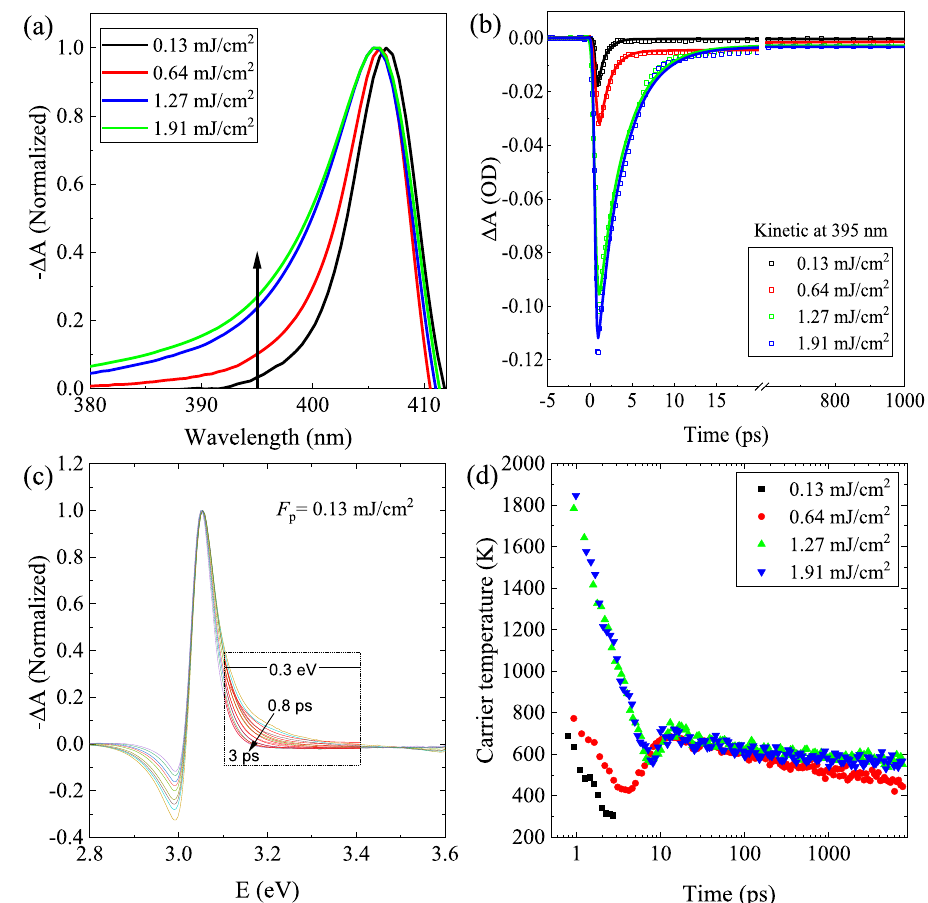
Fig. 7|Pump fl uencedependent hotcarriercooling dynamics.a NormalizedTA spectra around the peak at 406nm under different pump fl uences with fi les of 395nm bleach under different pump fl uences. λ p =320nm. b Kinetic pro c Normalized TA spectra at different time delays ( F p ~0.13mJ/cm 2 ), with the high